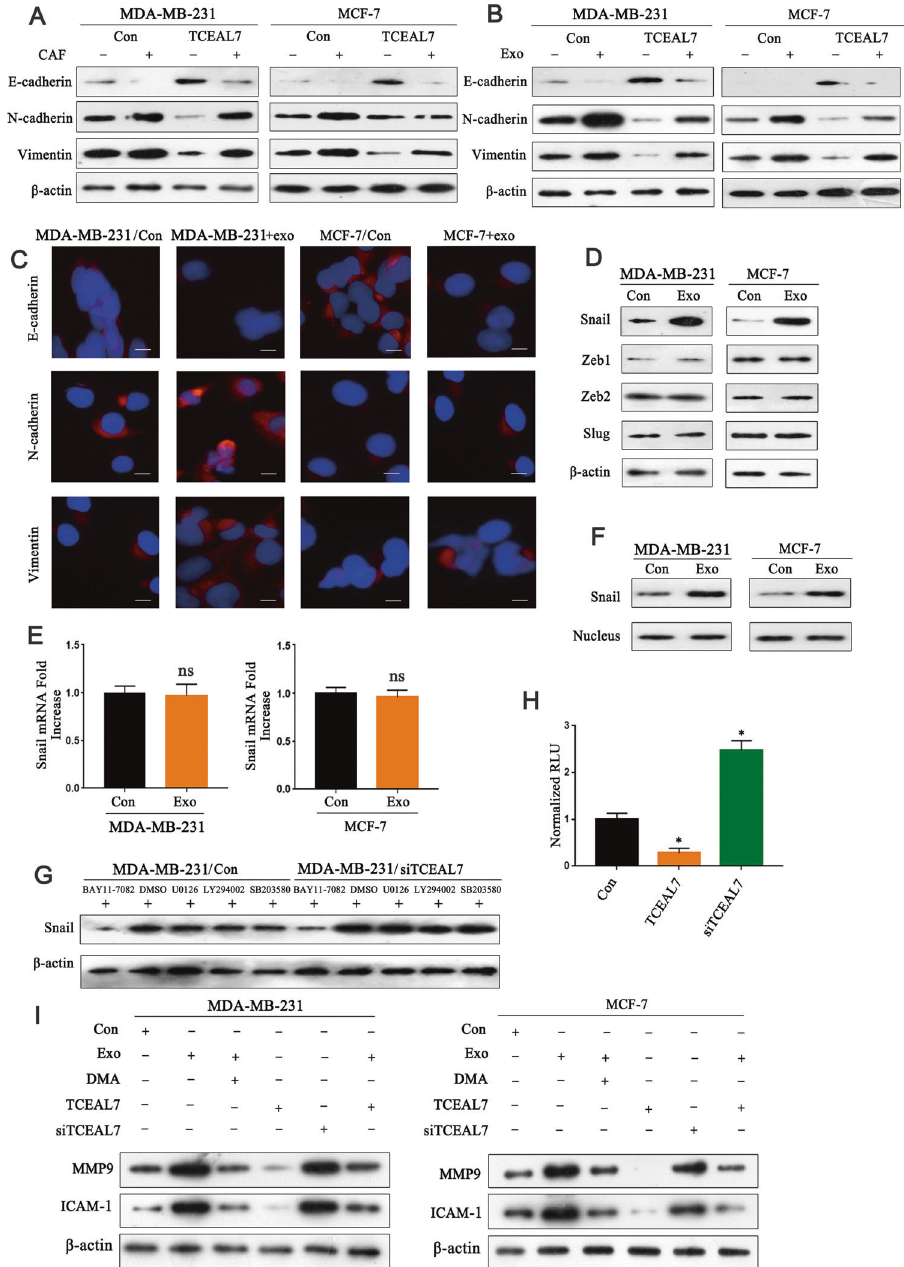
Fig. 6 TCEAL7 reverse EMT by activating the NF- κ B pathway. A Western blot analysis of the expression of E-cadherin, N-cadherin, and Vimentin in MDA-MB-231 cells after co-cultured with CAFs, and similar from MCF-7 cells ( n = 3). B Western blot analysis the expression of E- cadherin, N-cadherin, and Vimentin in MDA-MB-231 cells after co-culturing with CAFs-derived exosomes, similar from MCF-7 cells ( n = 3). C Cell immuno fl uorescence staining con fi rms Western blot results ( n = 3). D The expression levels of upstream transcription factors of EMT such as Slug, Snail, Zeb1 and Zeb2 were detected by Western blot ( n = 3). E The expression of Snail at the mRNA level in MDA-MB-231 cells and MCF-7 cells co-cultured with CAFs-derived exosomes ( n = 3). F The expression of Snail at the protein level in MDA-MB-231 cells and MCF-7 cells co-cultured with CAFs-derived exosomes ( n = 3). G Western blot to verify the effects of different inhibitors on Snail stability ( n = 3). H Effection of TCEAL7 on NF- κ B activation by luciferase assay ( n = 3). I Western blot was used to detection of NF-kB target genes: matrix metalloproteinase 9 (MMP9), intercellular adhesion molecule-1 (ICAM-1) proteins ( n = 3). * indicates p < 0.05. The measurement data were expressed using mean ± SD, and the experiment was repeated three times. Comparisons between two groups are analyzed by t-test; one-way ANOVA was used for multiple groups of data protease to affect cell invasion and movement [3, 40, 41]. This co-culturing with cancer cells, promoting tumor progression study compared the effects of CAFs and NFs on tumor cells and through speci fi c communication with cancer cells [38, 39]. CAFs showed that CAFs promoted cell proliferation, migration, and can increase the proliferation of cancer cells by secreting metastasis. stromal cell-derived factor 1 (SDF1) or produce ECM-degrading